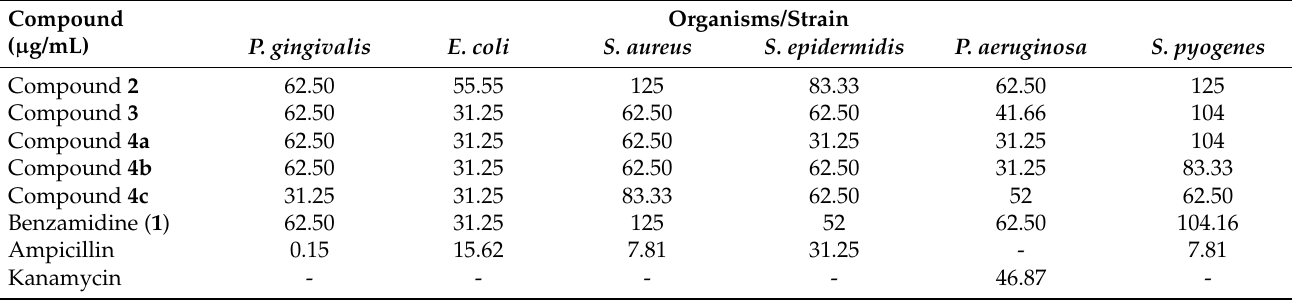
Table 1. MIC values for